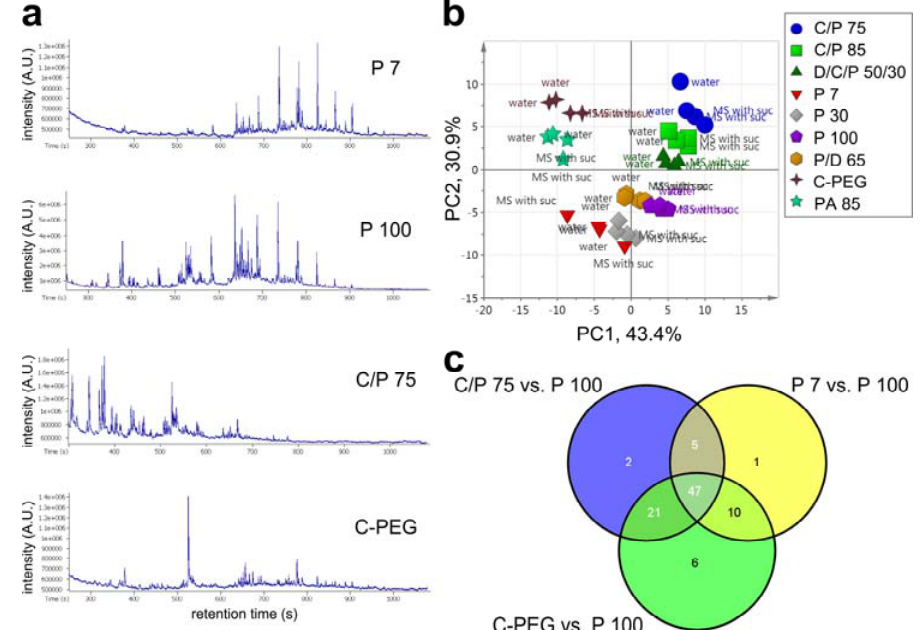
Figure 3. Collection efficiency of HS-VOCs by using various solid phase microextraction (SPME) fibers. (a) Total ion chromatograms (TICs) of VOC profiles collected by using a 7- μ m polydimethylsiloxane (PDMS) fiber (P 7), a 100- μ m PDMS fiber (P 100), a 75- μ m carboxen/PDMS fiber (C/P 75) and a carbowax-polyethylene glycol fiber (C-PEG). X-axis represents retention time, while the Y-axis shows peak intensity. (b) Principal component analysis (PCA) score scatter plot of VOC profiles using nine SPME fibers (observation: samples, n = 36; variables: annotated peaks, n = 99). Four independent samples were analyzed using each SMPE fiber. HS-VOCs were collected from Arabidopsis seedlings grown in water and MS conditions ( n = 2 each). (c) Venn diagram of the annotated peaks that showed significant changes in the profiles of (i) the 75- μ m C/P (blue), (ii) the 7- μ m PDMS (yellow) and (iii) the C-PEG fiber collection (green) when compared to those collected by the 100- μ m PDMS fiber. The number in the blue circle represents how many annotated peaks showed significant changes in the profiles from the HS-GC-TOF-MS analysis by using the 75- μ m C/P fiber. The number in the yellow circle represents the number of significant peaks in the profile from the 7- μ m PDMS analysis. The number in the green circle represents the number of significant peaks in the HS profile from the C-PEG fiber collection. Control, the HS profile collected by the 100- μ m PDMS fiber (see Table 1). Abbreviation: PC, principal